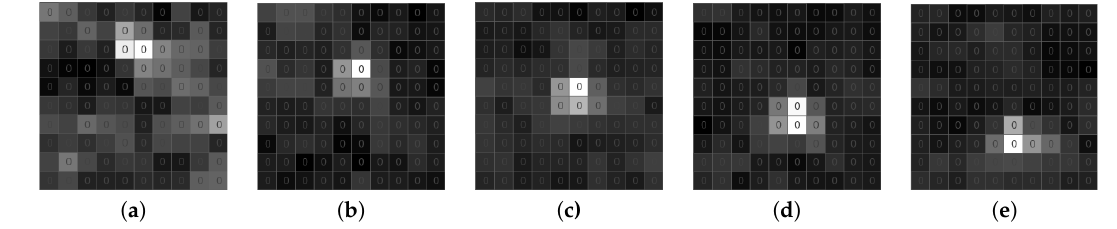
Figure 16. False negative example. ( a ) Time T. ( b ) Time T + 15 ms. ( c ) Time T + 30 ms. ( d ) Time T + 45 ms. ( e ) Time T + 60